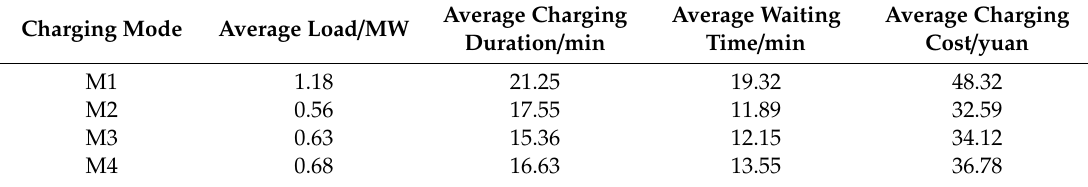
Figure 17. Charging demand load for different charging modes. Table 3. Comparison of service indicators of di ff erent charging modes. Table 3. Comparison of service indicators of different charging modes.